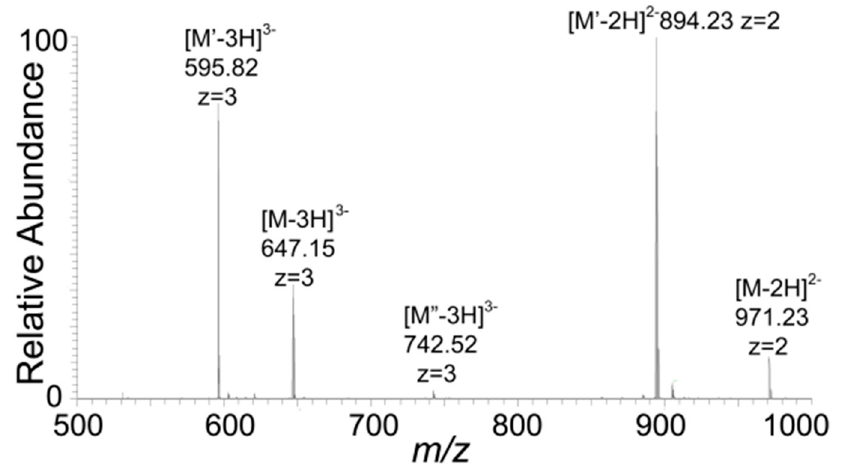
Figure 5. MS spectrum of resistant fraction 1’. The spectrum matches that of a major component ∆ UA-Kdo 7 -glycerol (M’), a minor component Δ UA-Kdo 7 -glycerol (M’), a minor component ∆ UA-Kdo 7 -PG (M), and a minor component ∆ UA-Kdo 9 -glycerol ∆ UA-Kdo 9 -glycerol (M’’).